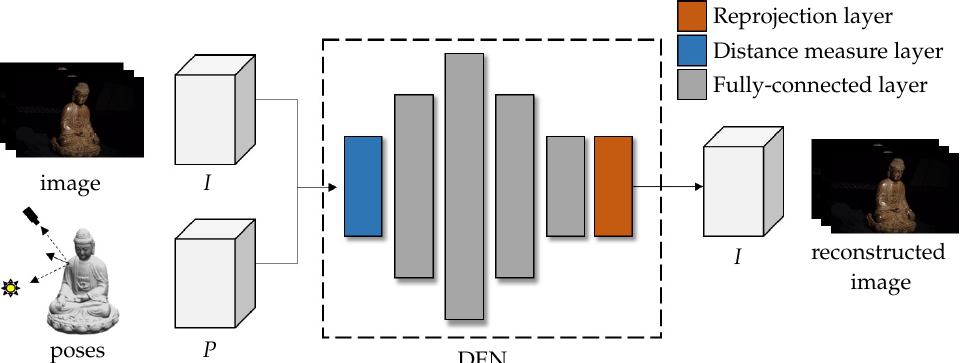
Figure 2. Overview of our method. From two input tensors ( I , P ), the DEN reconstructs the input I by updating the parameters of the network through the rendering loss for the basis BRDFs and the latent features (Section 4.2). The encoder which maps the input I into the latent space consists of the distance-measure layer and the fully-connected layers. The single-layer decoder (Reprojection layer) reproduces the input I from the encoded